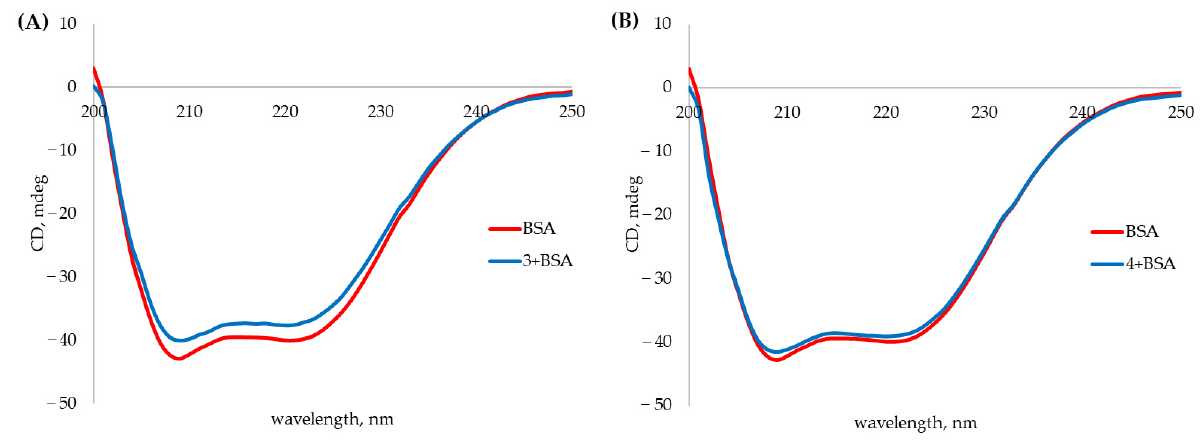
Figure 4. Circular dichroism spectra of ( A ) BSA (3.3 × 10 − 7 M) and the associate of 3 (3.3 × 10 − 6 M) with BSA (3.3 × 10 − 7 M) in buffer at pH 7.4; ( B ) BSA (3.3 × 10 − 7 M) and the associate of 4 (3.3 × 10 − 6 M) with BSA (3.3 × 10 − 7 M) in buffer at pH 7.4.